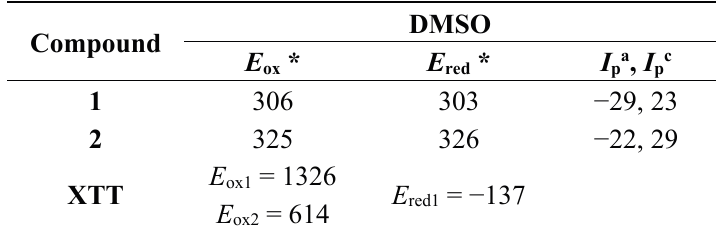
Table 3. Results of cyclic voltammetry measurements.